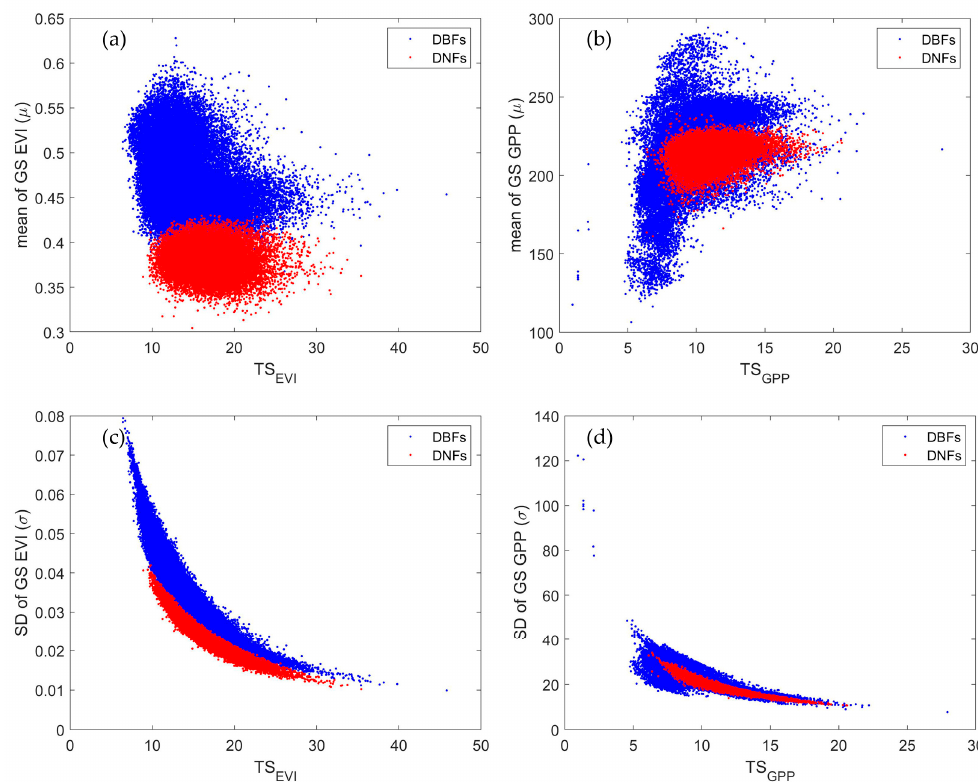
Figure 4. The temporal stability (TS) of forests versus the corresponding mean and standard deviation in North China, 2001–2018. The subplots are ( a ) TS calculated from growing season (GS) EVI (TS EVI ) vs. mean value of GS EVI; ( b ) TS calculated from GS GPP (TS GPP ) vs. mean value of GS GPP; ( c ) TS EVI vs. standard deviation (SD) of GS EVI; ( d ) TS GPP vs. mean value of GS GPP, for each valid forest pixels in this study. The blue dots are deciduous broadleaf forest grids. The red dots are deciduous needleleaf forest grids.